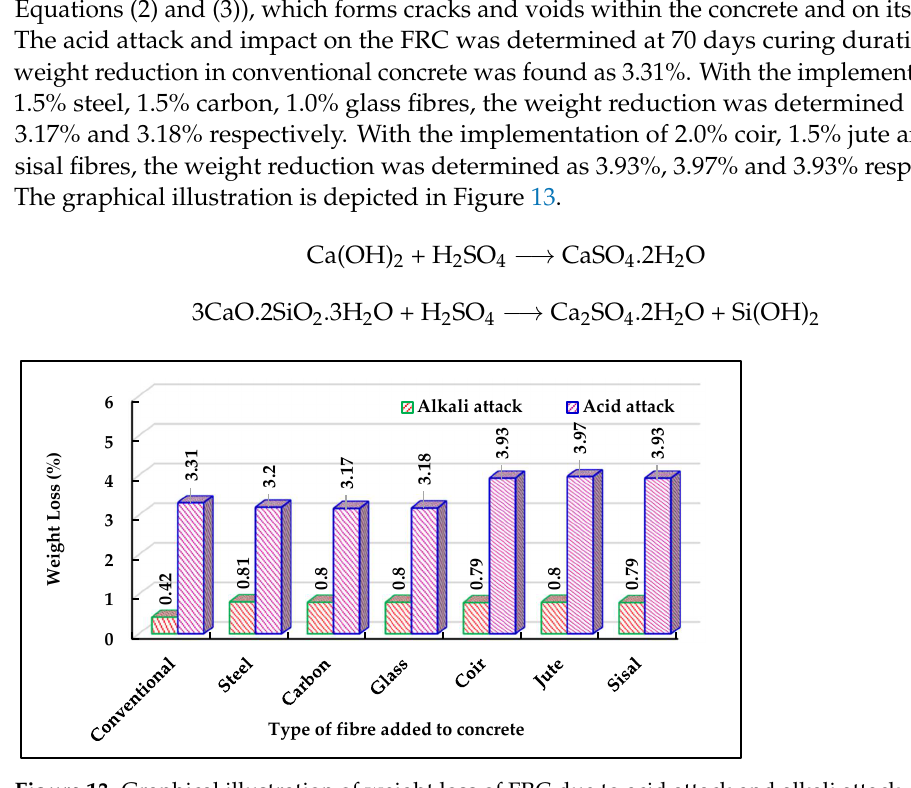
Figure 13. Graphical illustration of weight loss of FRC due to acid attack and alkali attack.